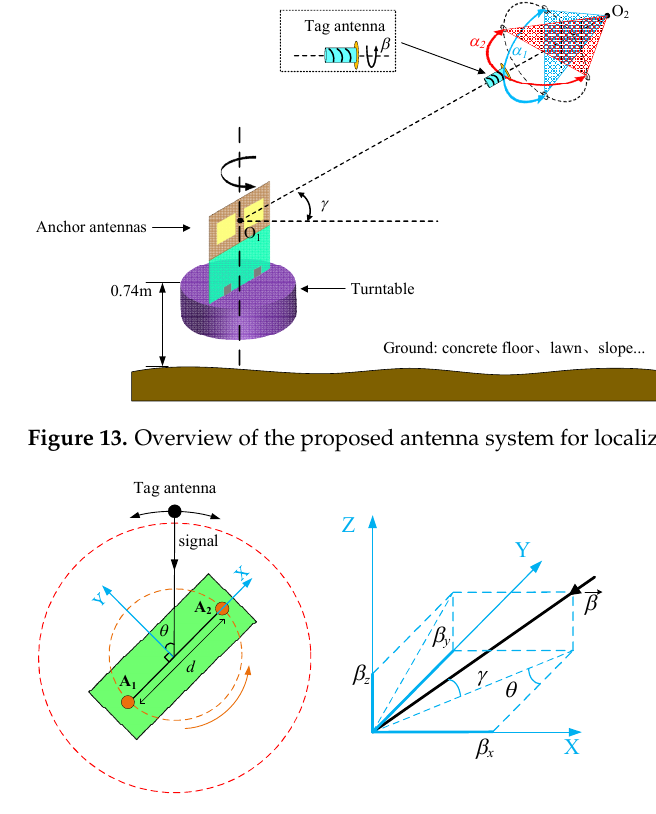
Figure 14. Anchor side with two linearly polarized elements and their interaction with the propa- gation vector of an incoming plane wave.